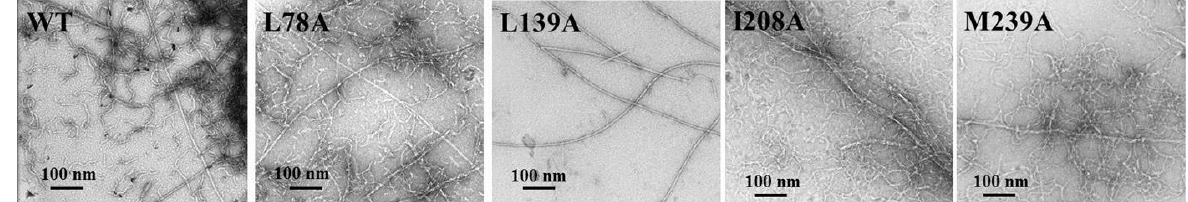
Figure 6. Electron micrographs of amyloid aggregates of wild-type carbonic anhydrase and its mutant forms after reaching the plateau of kinetic curves (for WT — 17 days of incubation, for forms after reaching the plateau of kinetic curves (for WT—17 days of incubation, for L78A—23 days, L78A — 23 days, for L139A and M239A — 25 days, for I208A — 14 days). for L139A and M239A—25 days, for I208A—14